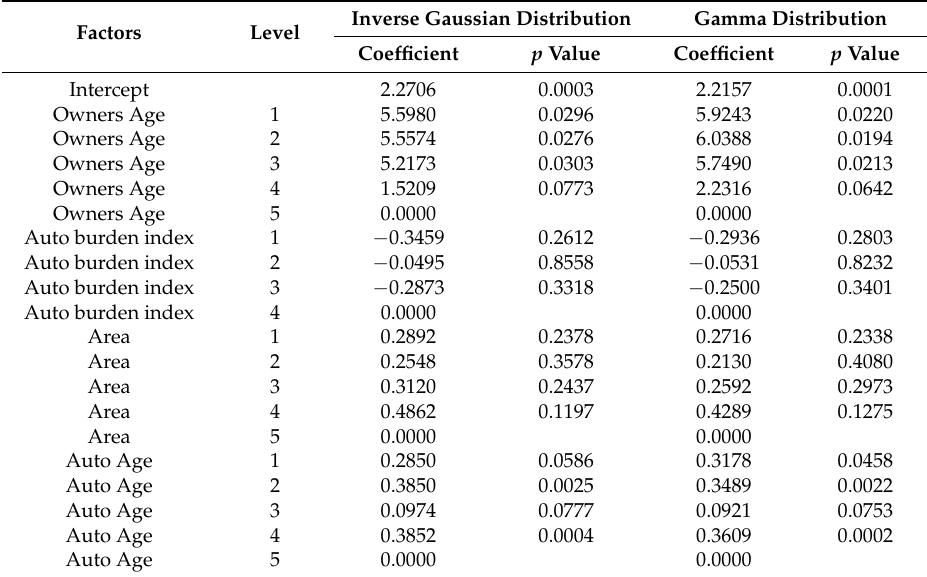
Table 6. The claim cost fitted by two